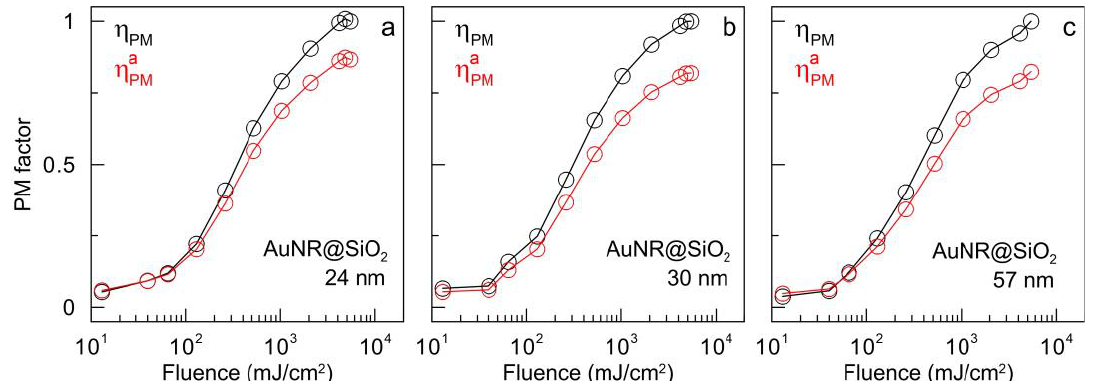
Figure 11. PM factor η PM (black curve) and approximate PM factor η a P M of fluence for gold nanorods with different silica shell thicknesses: 24 ( a ), 30 ( b ), and 57 ( c ) nm. Sometimes, it is not possible to carry out the entire series of PM experiments to ensure